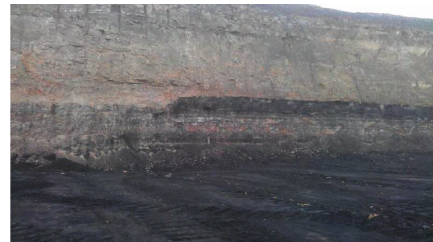
Figure 6: Destruction degree of coal seam